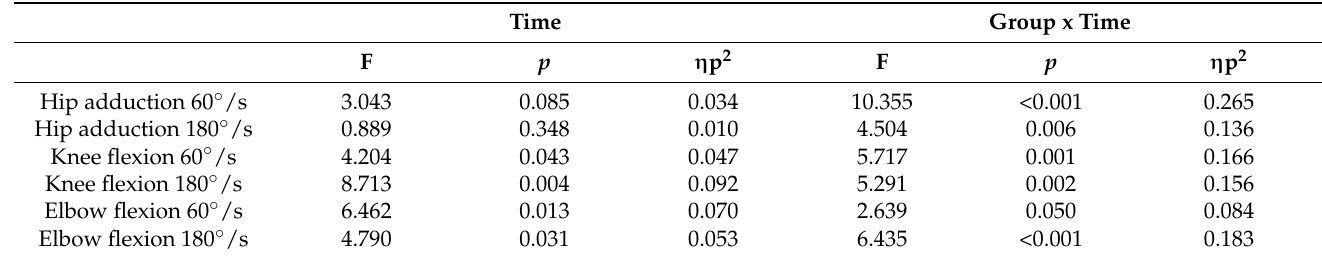
Table 2. Results of the ANOVA on isokinetic neuromuscular strength.